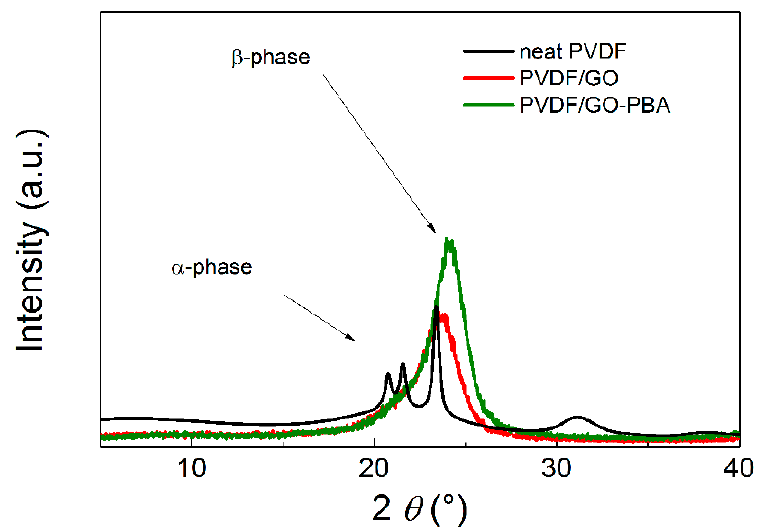
Figure 9. XRD spectra of the neat PVDF and composites containing PVDF/GO and PVDF/GO-PBA particles.